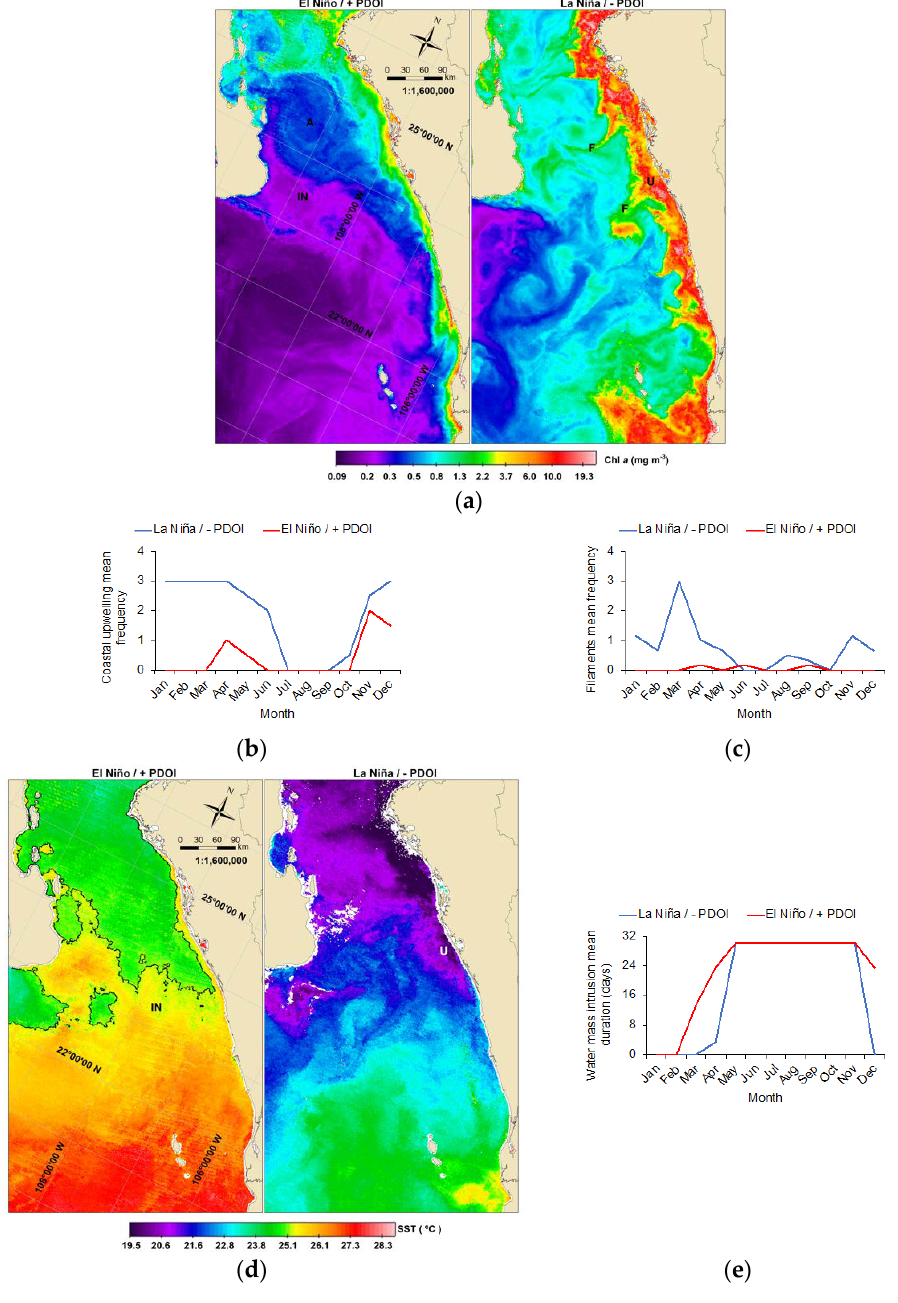
Figure 10. ( a ) Chlorophyll a satellite images exhibiting El Niño/+PDOI and La Niña/−PDOI conditions in the Central Gulf of California; ( b ) Mean annual frequency of anticyclonic eddies during positive and negative ENSO/PDO; ( c ) Mean annual frequency of coastal upwelling during positive and negative ENSO/PDO; ( d ) Sea surface temperature satellite images exhibiting El Niño/+PDOI and La Niña/−PDOI conditions in the Central Gulf of California; ( e ) Mean annual duration of the water mass intrusion during positive and negative ENSO/PDO.